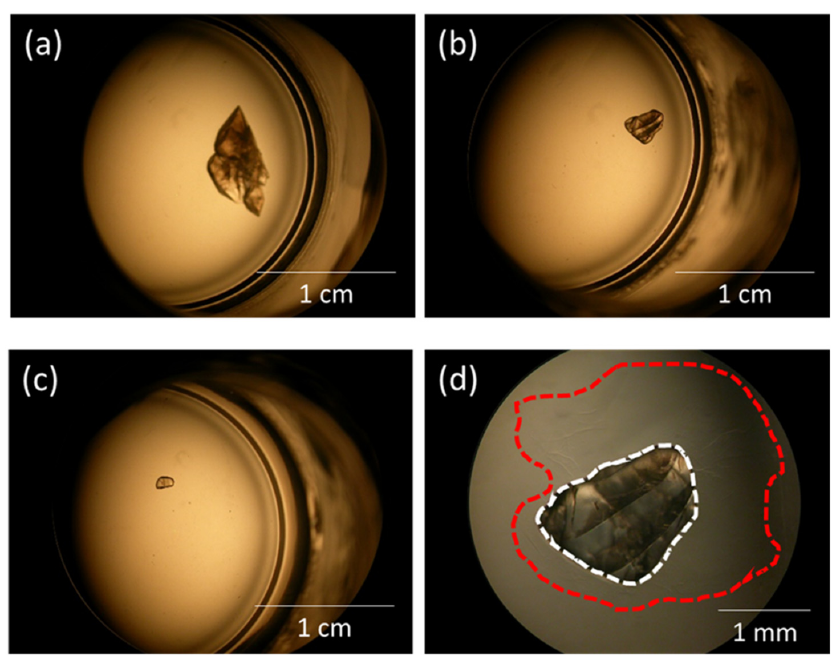
Figure 2. Dissolution of a form I crystal grown in agarose (1.0% ( w / v )). ( a ) Before the experiment. ( b ) After two hours. ( c ) After four hours. ( d ) After two hours and 40 min. The white dotted line shows the outline of the crystal being dissolved, and the red dotted line shows the outline of the agarose gel being dissolved.